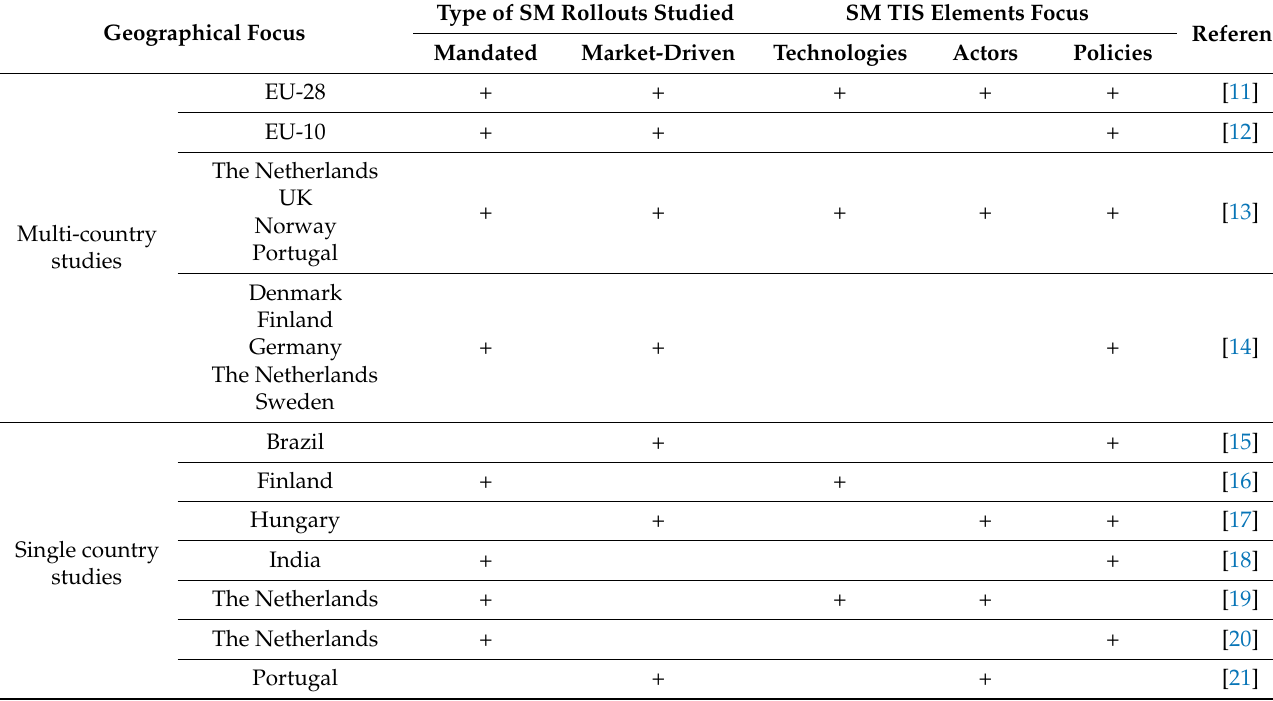
Table 1. Prior related works on TIS of SM